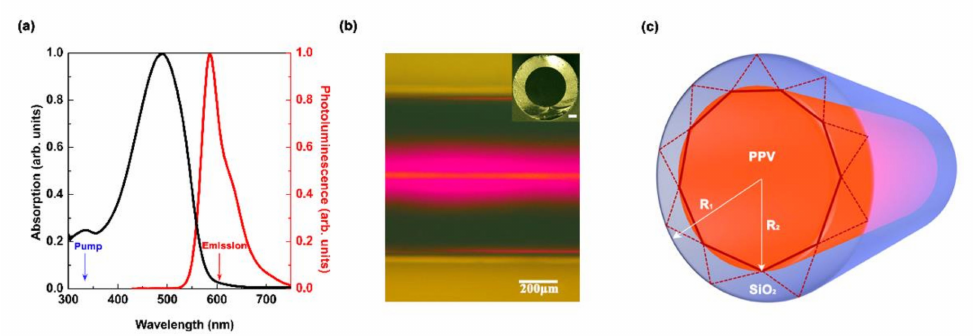
Figure 1. ( a ) Normalized photoluminescence (PL) spectrum (black) and absorption spectrum (red) of the conjugated polymer MDMO-PPV. The pump and emission wavelengths are shown by the blue and red arrows, respectively. ( b ) The optical micrograph of the device, with a scale bar of 200 µ m. The inset is the cross section of the capillary tube and the scale bar is 100 µ m. ( c ) Schematic diagram of the whispering-gallery-modes (WGMs) origin in capillary tube microcavity. There are two split rays caused by reflection/refraction, which are denoted by solid (dotted)